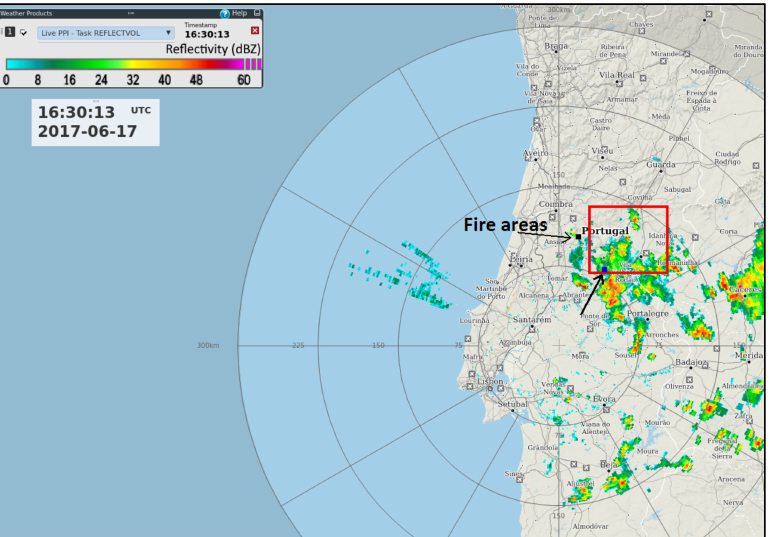
Figure 8. PPI of reflectivity, 0.1 ◦ tilt, 16:30 UTC, 17 June 2017, C/CL radar. Range rings are marked every 75 km. The red square delimits the area where a manual method was applied to determine the storm motion of the Mesoscale Convective System during the period 14:30–16:30 UTC. Fire areas are depicted by an arrow. The location Proença-a-Nova of the sounding mentioned in Figure S2 is also depicted by an arrow to the southeast of the fire